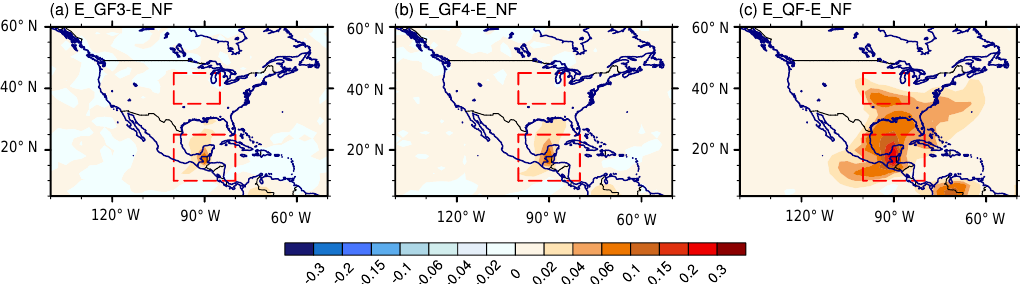
Figure 6. Spatial distributions of 10-day-average (1–10 April) ensemble mean AOD differences between simulations with (E_GF3, E_GF4, and E_QF) and without (E_NF) fire